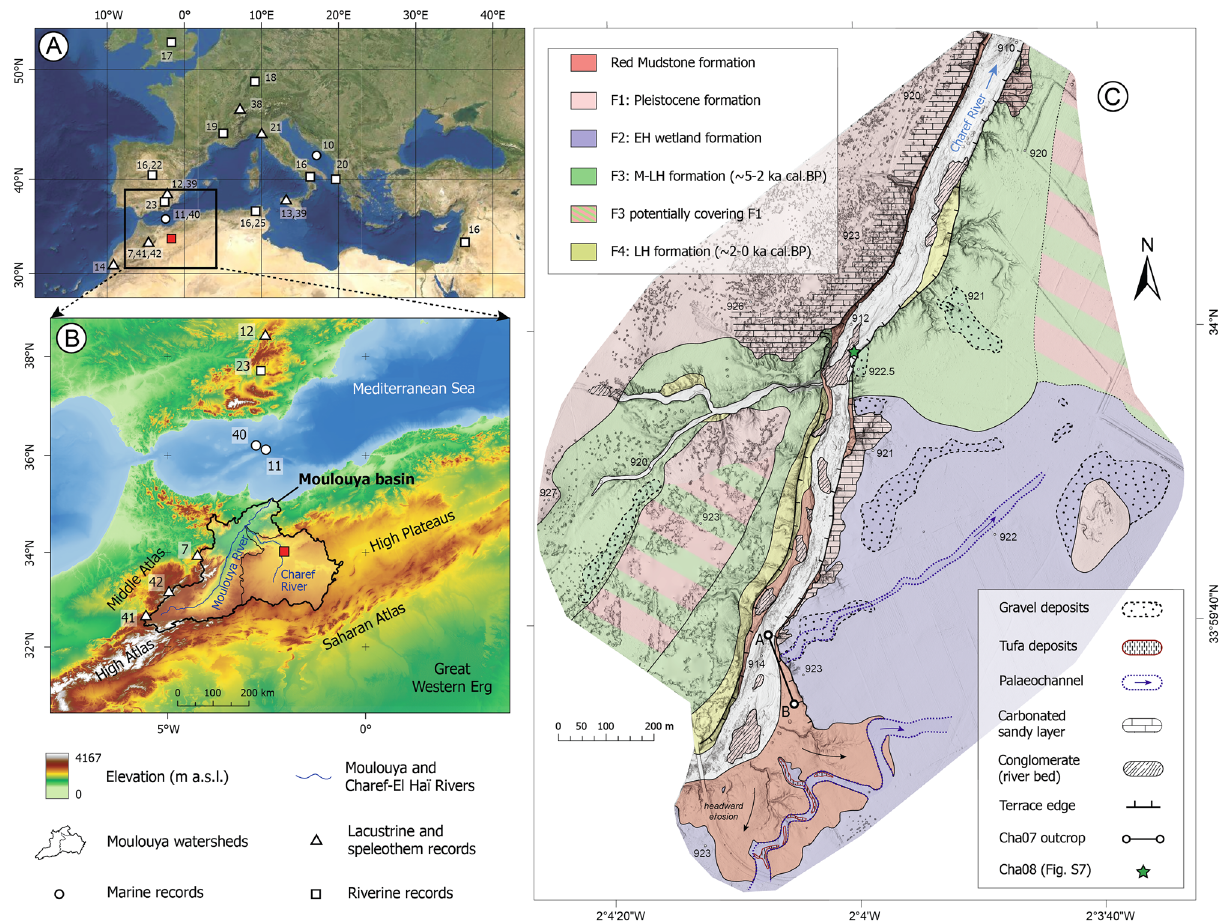
Figure 1. Geographical setting. ( A ) Location of the studied area and the references discussed in the Mediterranean basin (the numbers refer to the studies referenced in the text), and ( B ) within the topographic frame of NW Africa. ( C ) Geomorphological map of the superficial sedimentary formations of the studied section of the Charef River. EH Early Holocene, MH Mid-Holocene, LH Late Holocene. Data source and software: ( A ) data from TerraColor imagery (https:// www. arcgis. com/ home/ item. html? id= 10df2 279f9 684e4 a9f6a 7f08f ebac2 a9), ( B ) data from ASTER GDEM2 (https:// lpdaac. usgs. gov/ produ cts/ astgt mv002/) both plotted by means of ArcGIS Pro [2.7] (https:// www. esri. com/ en- us/ arcgis/ produ cts/ arcgis- pro/), ( C ) map created by B. Depreux using Adobe Illustrator CC (https:// www. adobe.